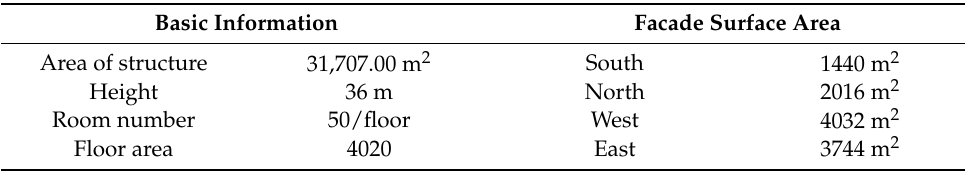
Table 1. Architectural information of on the research